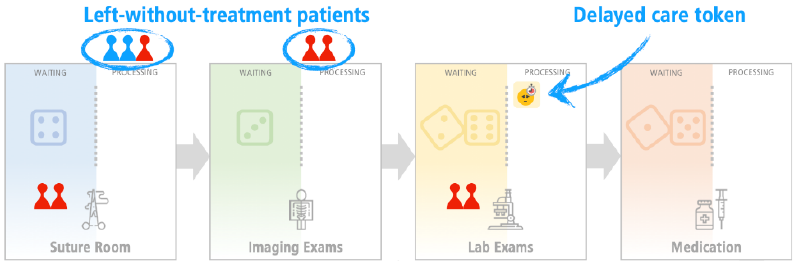
Figure 1. ( a ) Example of how to initially set up the board to play. ( b ) Implications of the patient- “batching” policy; notice some left-without-treatment patients (LWOT) on top of SUTURE ROOM and IMAGING EXAMS, while LAB EXAMS is at risk of receiving its second delayed care token.